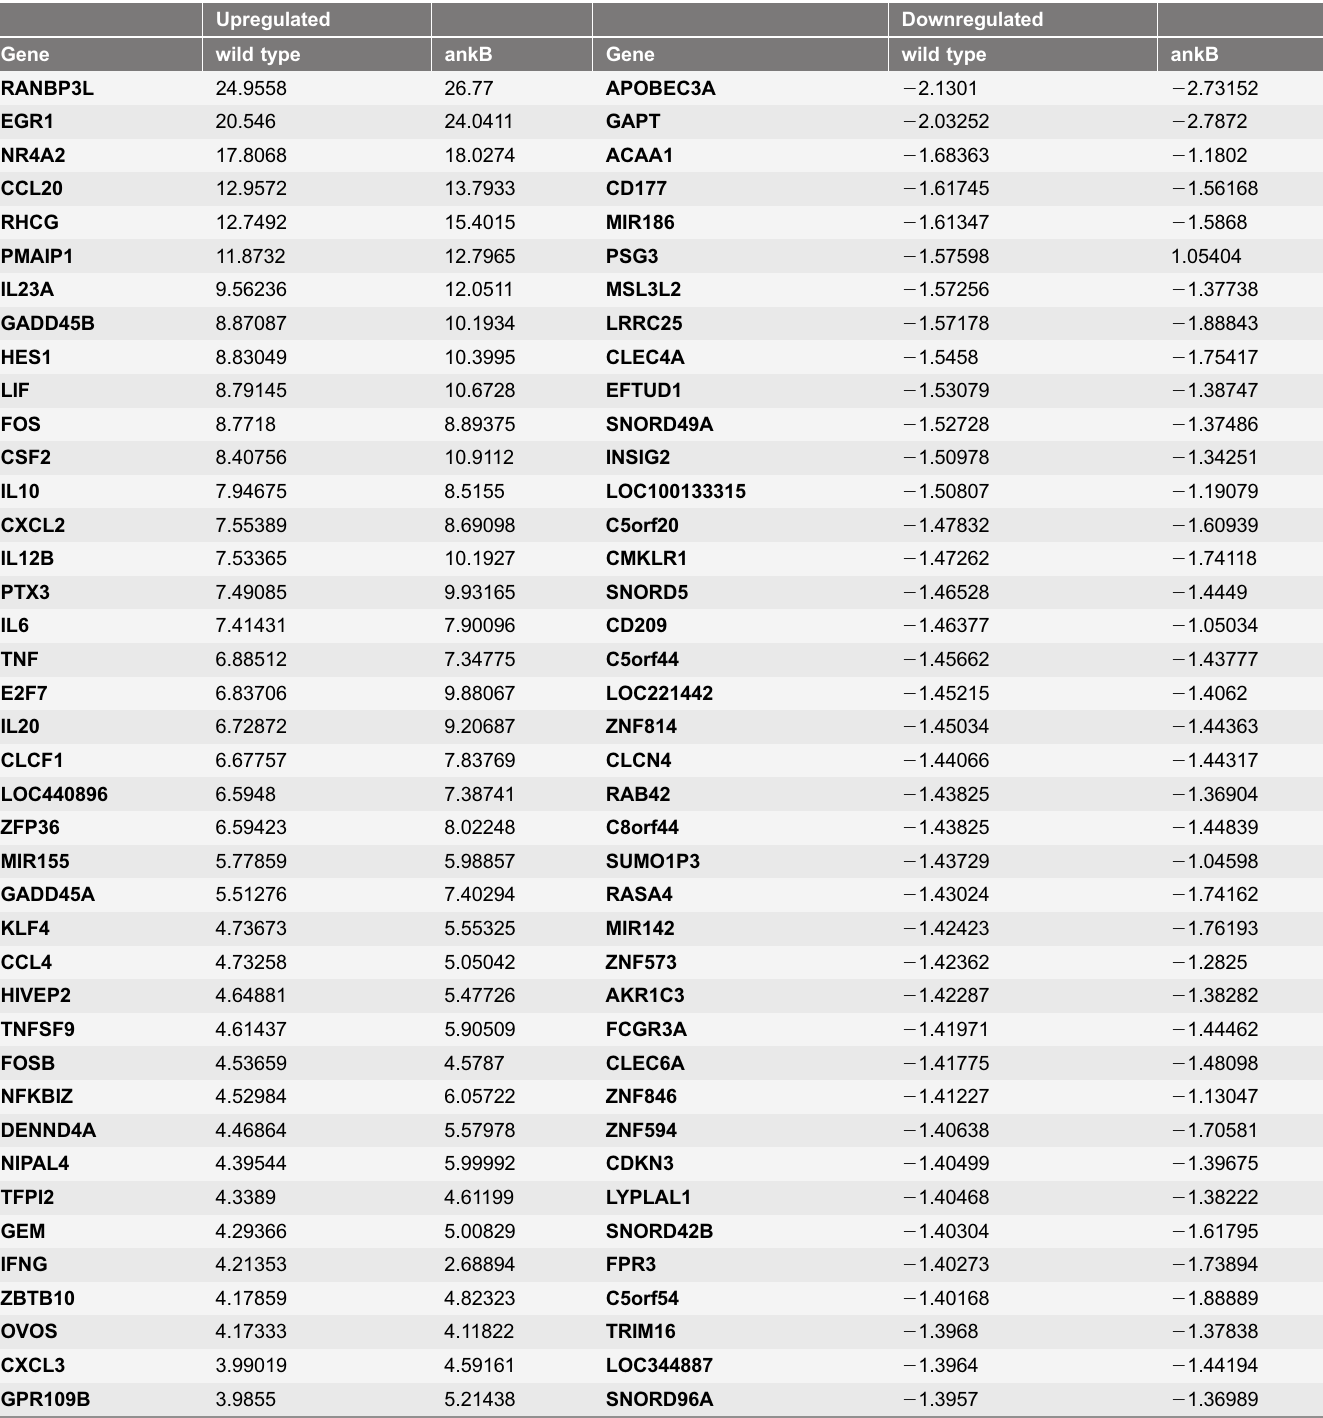
Table 1. The top 40 up- and down-regulated genes in hMDMs infected by either wild type or an isogenic ankB L. pneumophila mutant strain compared to uninfected hMDMs at 8 h